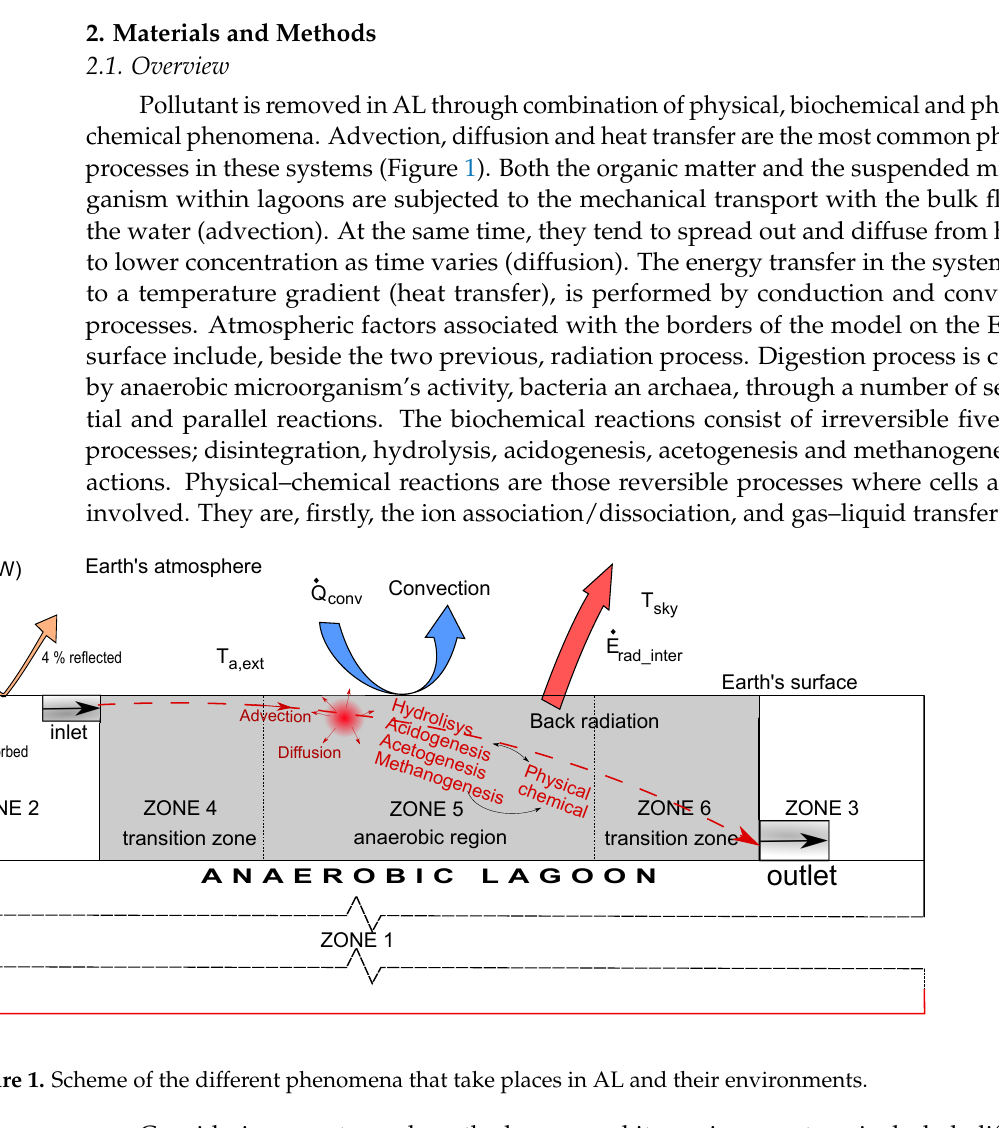
zones can be identified (Figure 1). Depending on the local parameters—thermal conductiv- ity, specific heat, density, and where biological processes take place—they are considered different zones. Boundary conditions are located on the borders. Undisturbed ground